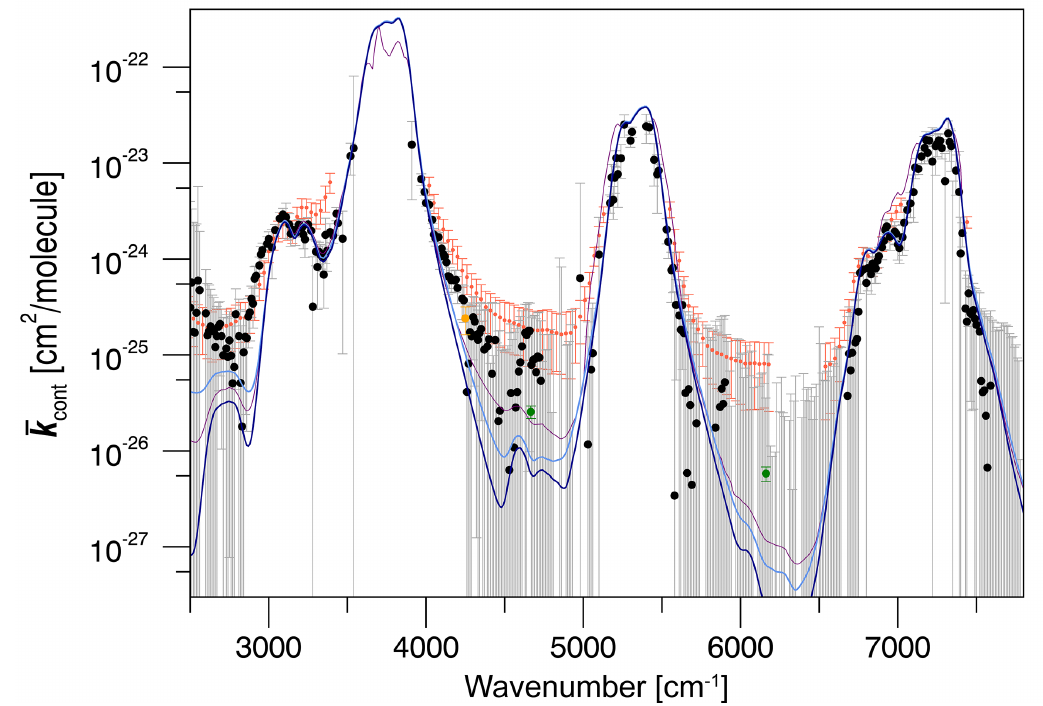
Figure B1. Mean continuum absorption coefficient ¯ k cont determined in the Zugspitze closure experiment and corresponding 2 σ uncertainties (black). Results are compared to the MT_CKD 2.5.2 model (self- and foreign continuum: light blue; foreign continuum: dark blue), the BPS-MTCKD 2.0 model (purple line), and the following laboratory studies carried out at room temperature or below: the CRDS measure- ments of Mondelain et al. (2015) (orange), the calorimetric–interferometric measurements of Bicknell et al. (2006) (green), and the FTIR measurements of Ptashnik et al. (2012, 2013) (red).